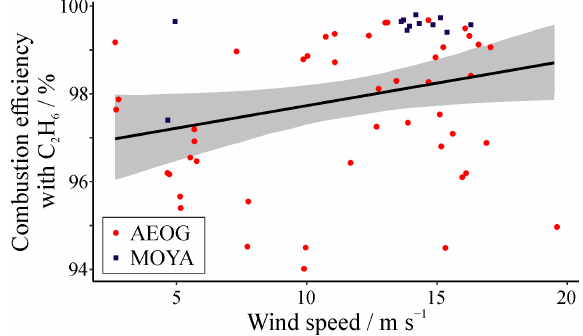
Figure 5. Correlation between combustion efficiency (calculated including C 2 H 6 ; Eq. 3) and wind speed (ms − 1 ). The wind speed for each plume was calculated as the mean of 1Hz wind speeds measured during and both 50s before and after the plume. The black line shows an ordinary least squares linear regression of the data ( p = 0 . 04, R 2 = 0 . 08), with the 95% confidence interval shown in